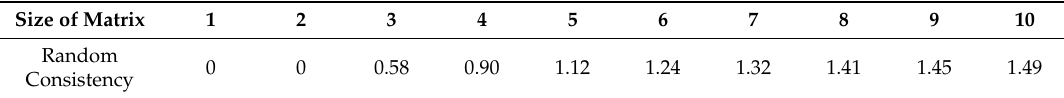
Table 3. Average random consistency index values for di ff erent values of n (source: Saaty and Kearns